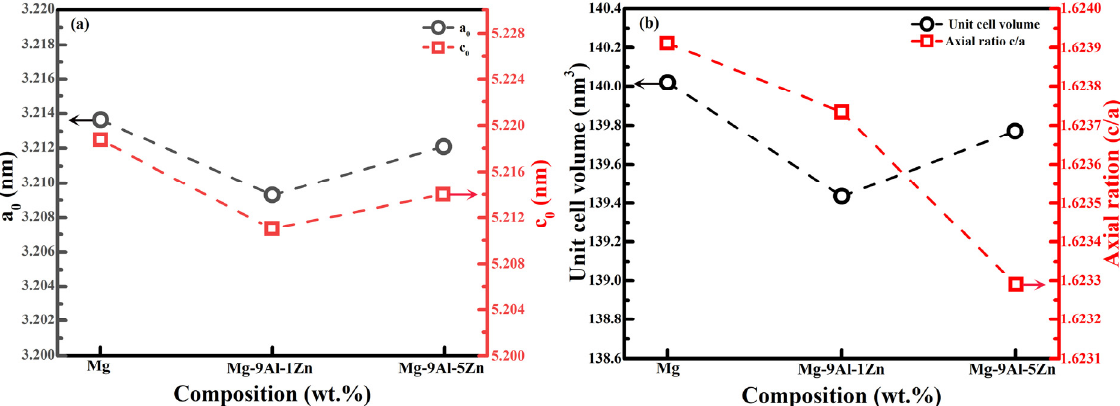
Figure 6. The lattice parameters dependence of the α -Mg phase on Zn content in the Mg-Al–Zn ternary system as determined by Rietveld refinement: ( a ) axes parameters; ( b ) cell volume and axial ratio.